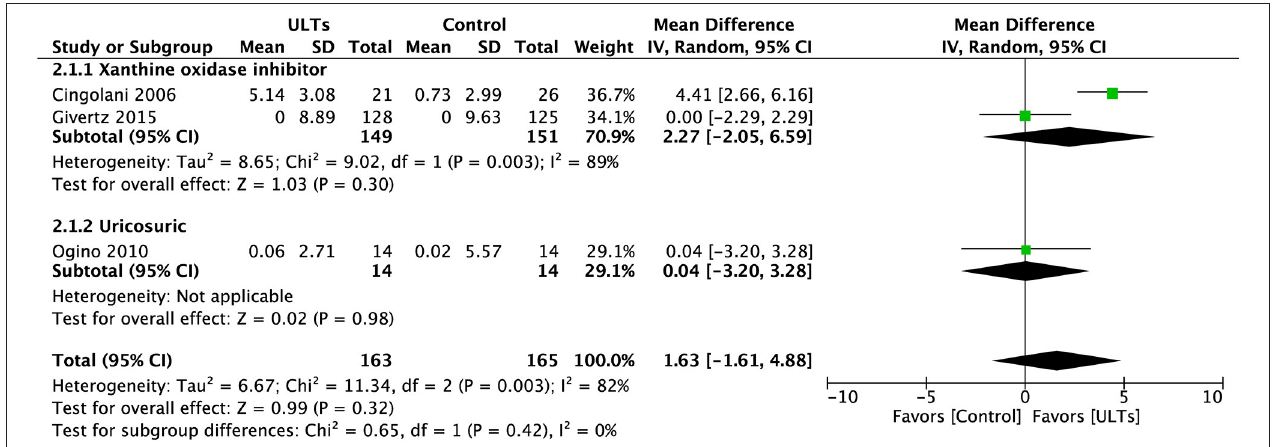
FIGURE 3 | Meta-analysis of left ventricular ejection fraction.